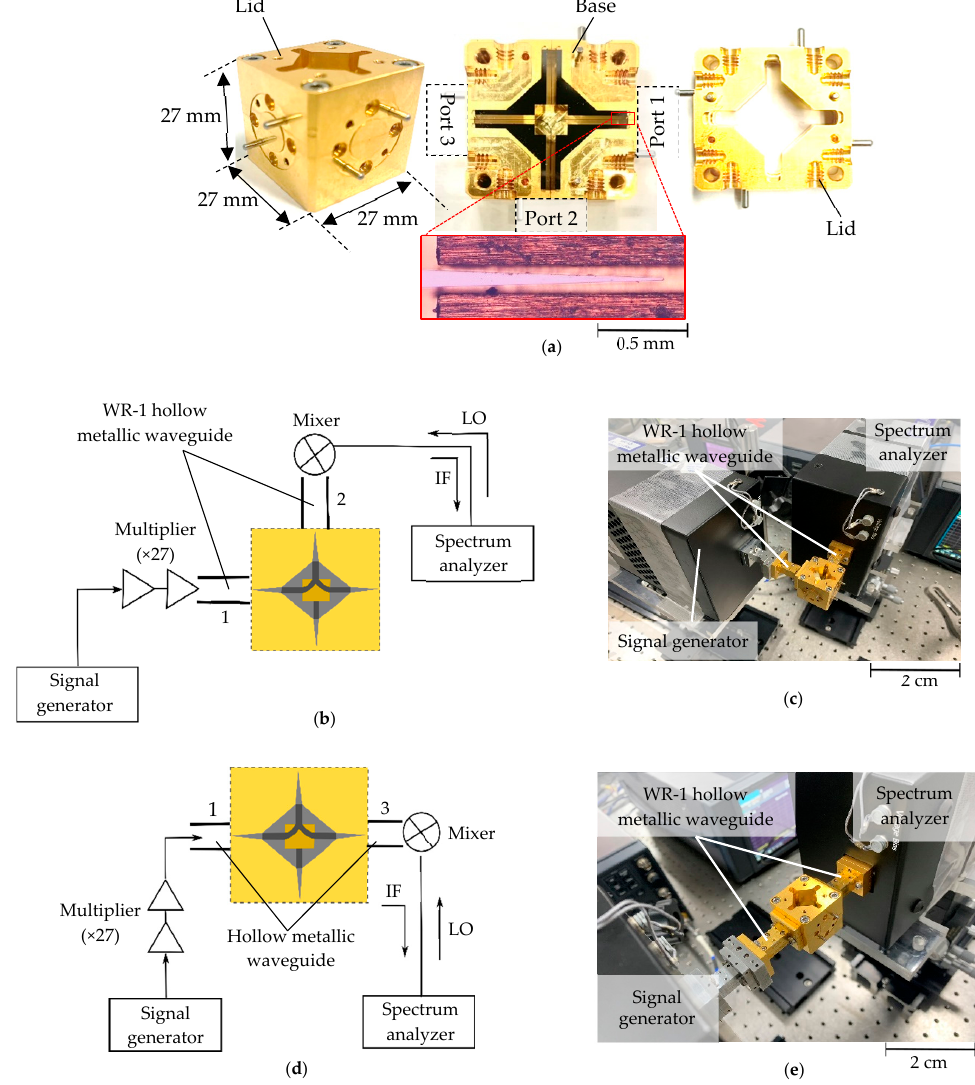
Figure 14. Y-branch measurement setup: ( a ) Fabricated module; ( b ) Block diagram for the measure- ment of S21; ( c ) Photograph of experiments setup for the measurement of S21; ( d ) Diagram for the measurement of S31; ( e ) Photograph of the experimental set up for the measurement of S31.